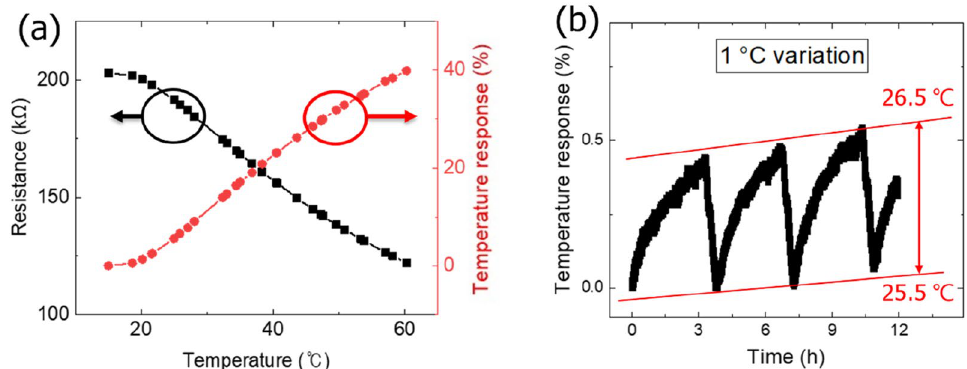
Figure 1. ( a ) Resistance variance and temperature response of rGO with respect to temperature sweep from 15 to 60 °C. ( b ) Temperature response of rGO for temperature variation of 1 °C and long-term